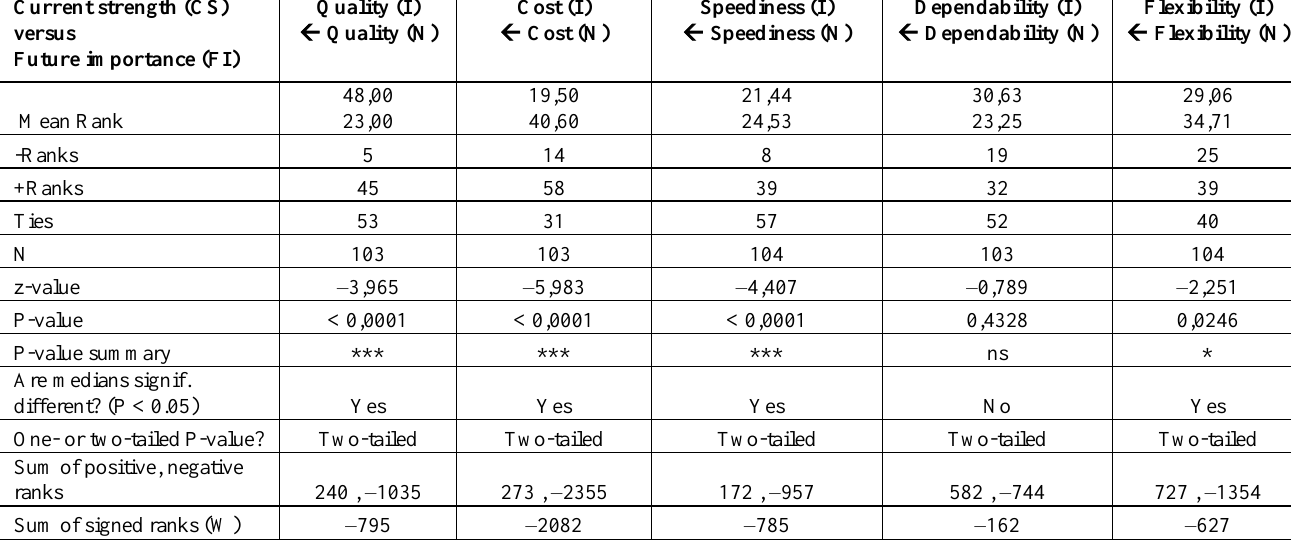
Table 9:Wilcoxon matched-pairs signed ranks rests: movement between decision points : NATIONAL Current strength (CS)